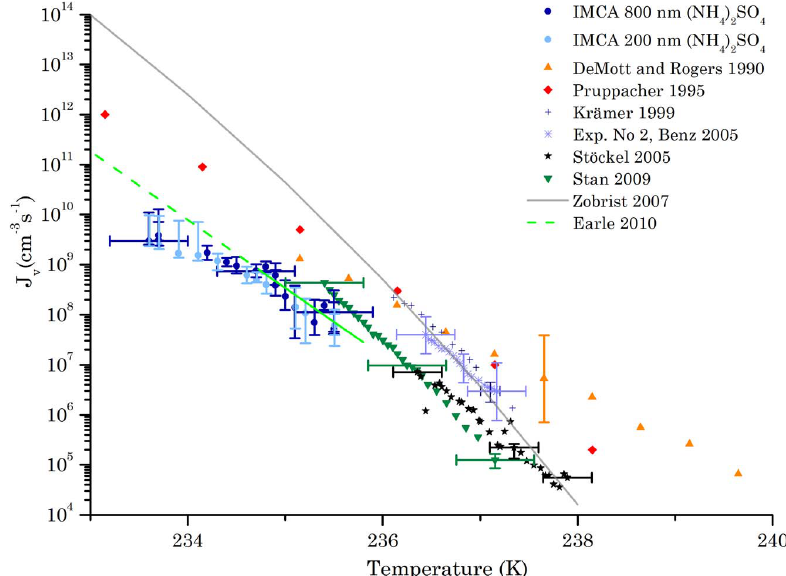
Fig. 6. The homogeneous nucleation rate of water in the temperature range 233K to 238K. The two sets of IMCA/ZINC measurements were made by CCN activation of 800nm and 200nm ( NH 4 ) 2 SO 4 particles, leading to water droplets with estimated diameters of